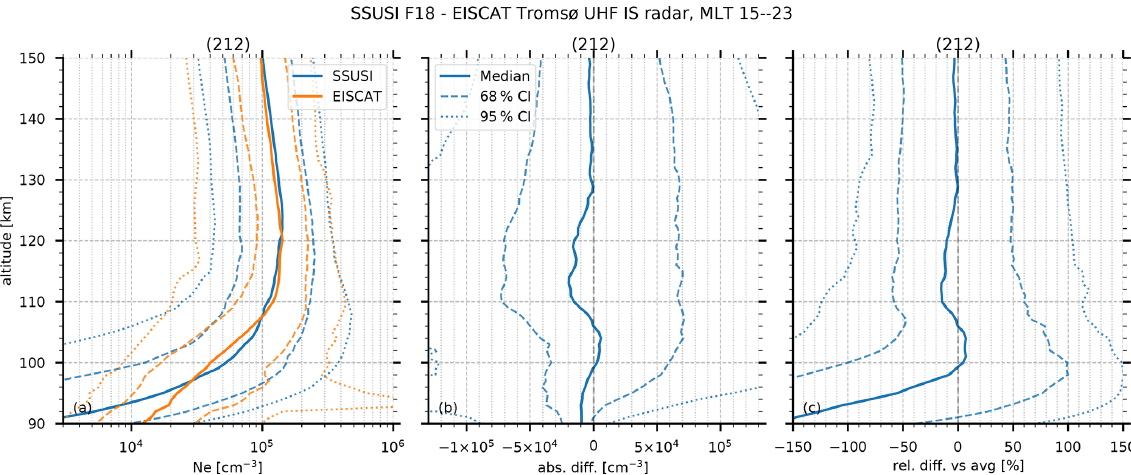
Figure 5. Profile comparison as in Fig. 4 for SSUSI on DMSP/F18 and the EISCAT Tromsø UHF radar for late MLT (15:00–23:00MLT).